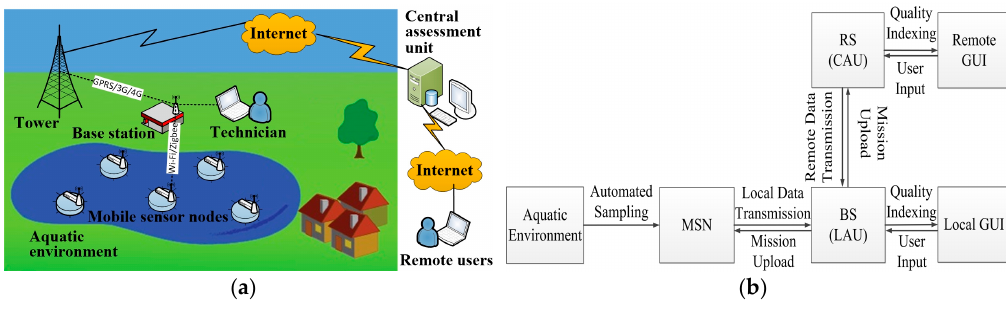
Figure 1. The proposed Internet of Things (IoT) platform: ( a ) Architecture of the platform for water quality monitoring; ( b ) Workflow diagram of the platform.